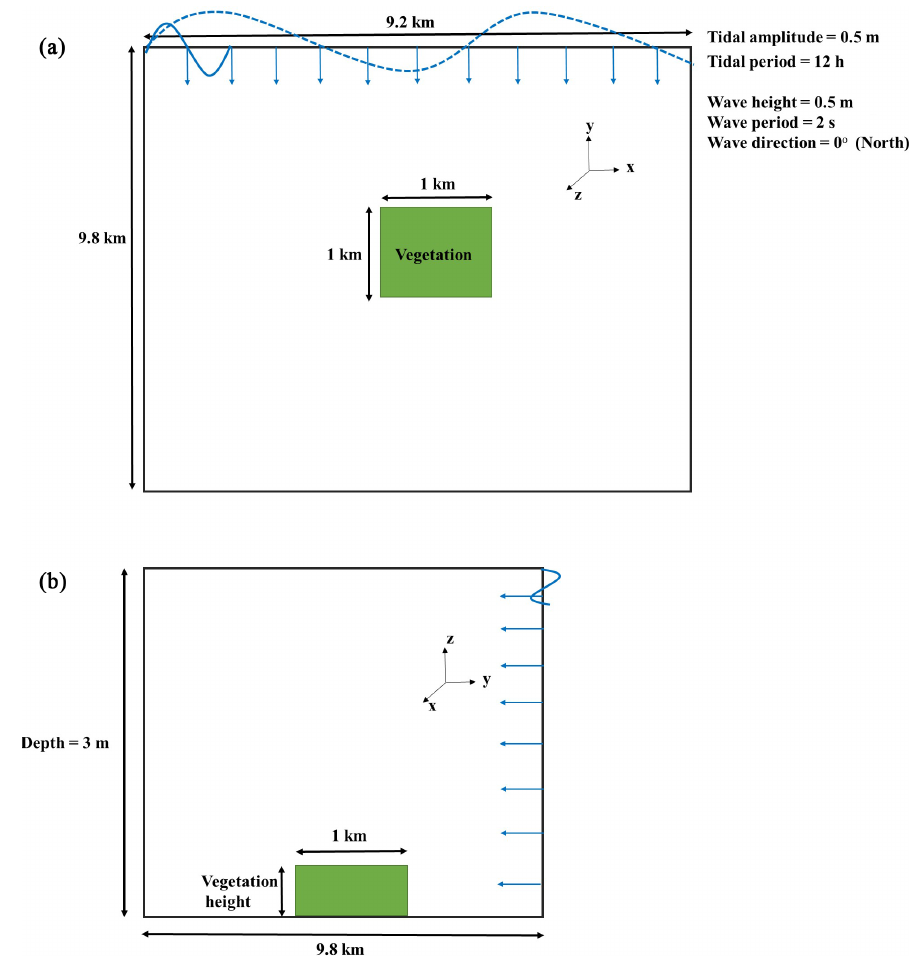
Figure 2. Schematic showing the idealized domain (not drawn to scale): (a) plan view and (b) cross-sectional